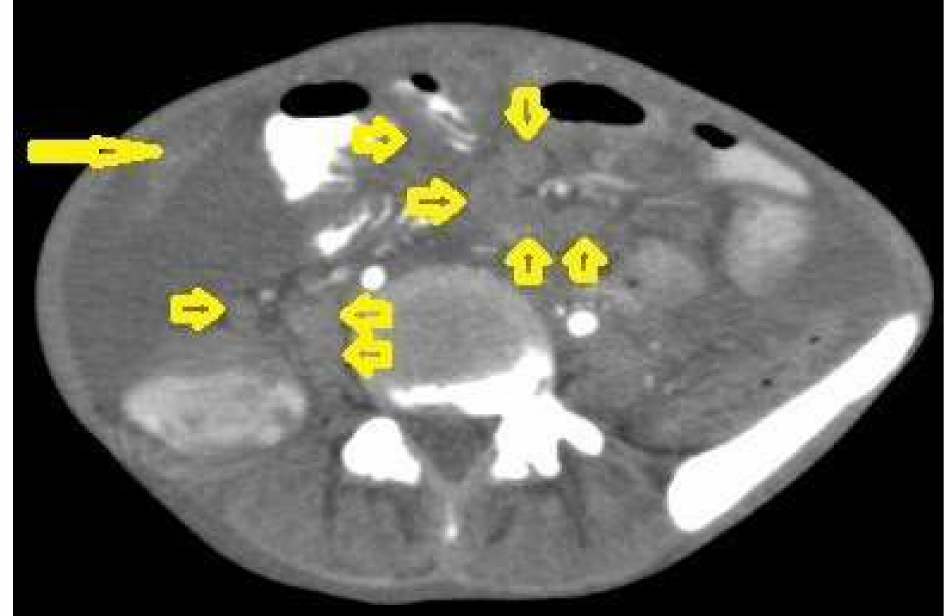
Figure 20. Tuberculous lymphadenitis in a 27-year-old women with cachexia, loss of appetite and cough. Axial abdominal CT image shows enlarged mesenteric, periaortic, and portahepatis lymph nodes (LNs), (short arrows) due to TB, which usually involves multiple groups, such as mesenteric and upper paraortic LNs. The image also shows relatively dense ascites and remarkable omental thickening forming cake-like mass (long